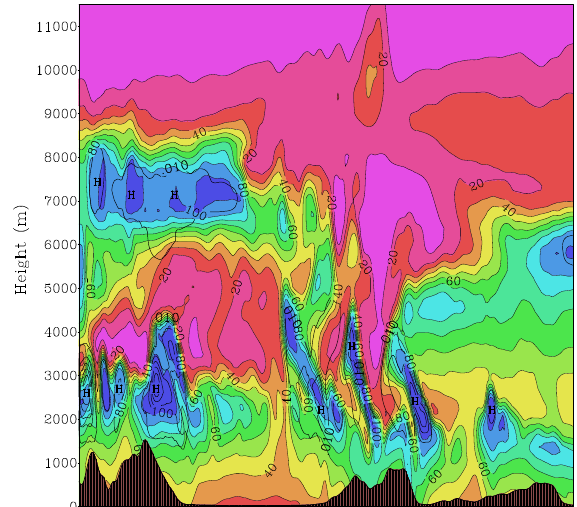
Fig. 9. Relative humidity (color) and water condensate (thick con- tours) at 09:30 UTC on section x1 (see Fig. 3).